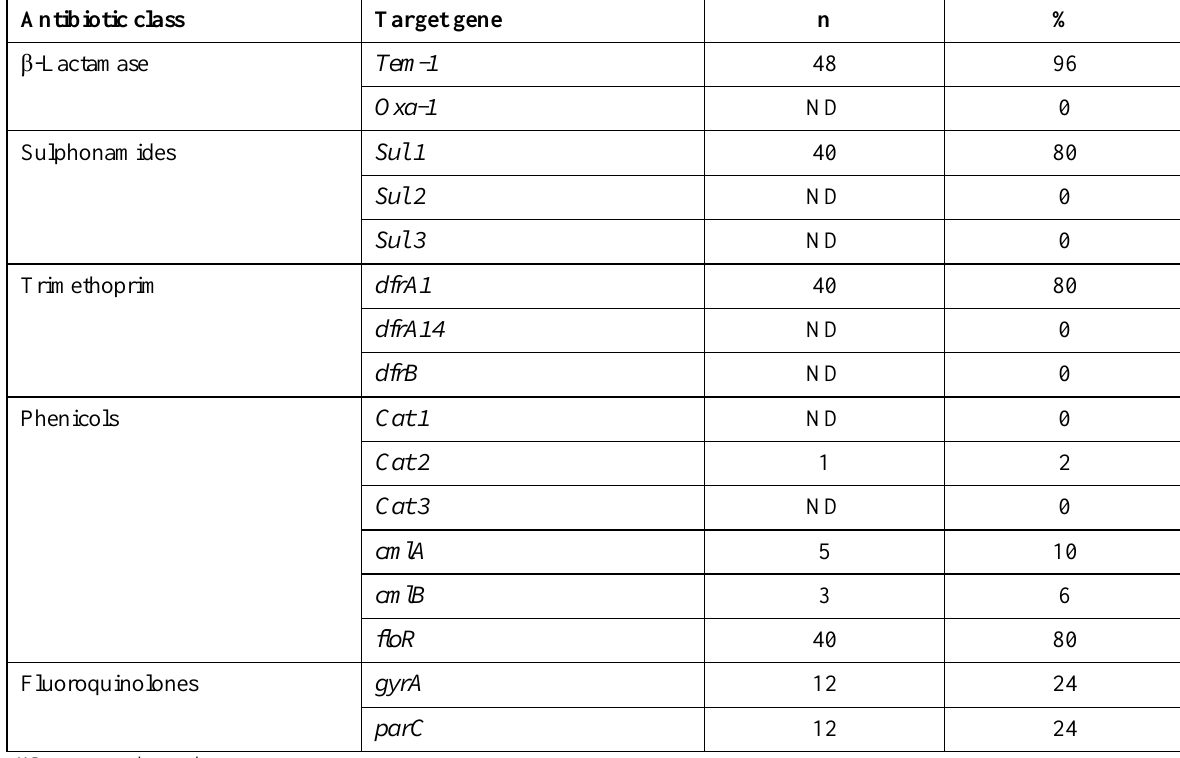
Table 4. Distribution of antimicrobial resistance genes in Salmonella clinical isolates.